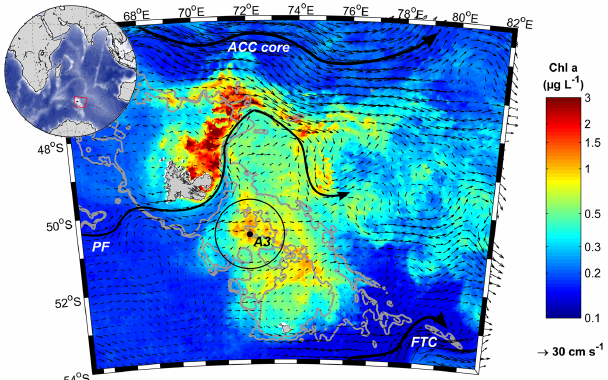
Figure 1. Localization of the Kerguelen Plateau in the Indian sec- tor of the Southern Ocean and detailed map of the satellite-derived surface chlorophyll a concentration (MODIS level 3 product) aver- aged over the sediment trap deployment period. Sediment trap loca- tion at station A3 is represented by a black dot, whereas the black circle represents the 100km radius area used to average the sur- face chlorophyll a time series. Arrows represent surface geostrophic circulation derived from the absolute dynamic topography (AVISO product). Positions of the Antarctic Circumpolar Current core (AAC core), the polar front (PF) and the Fawn Trough Current (FTC) are shown by thick black arrows. Grey lines are 500 and 1000m iso-